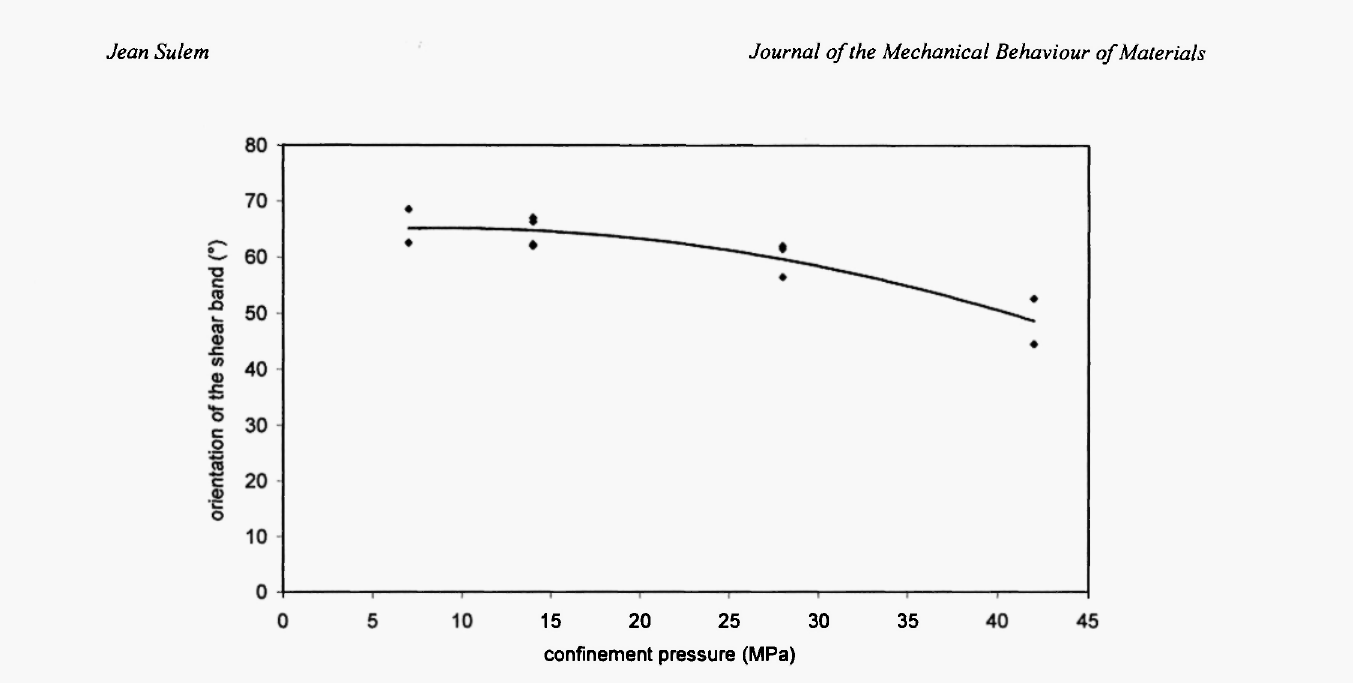
Fig. 6: Triaxial tests on a Fontainebleau sandstone: Effect of confining pressure on the orientation of the shear-band (from El Bied 2000 1261)